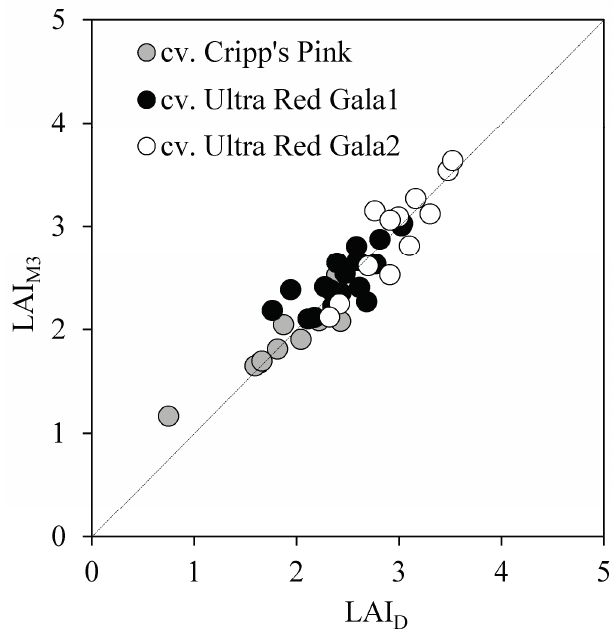
Figure 4. Comparison between leaf area index estimated by cover digital images considering instantaneous fraction of incident radiation absorbed by the canopy (LAI M3 ) vs. leaf area index obtained by defoliated method (LAI D ). Data shown considers all varieties and study